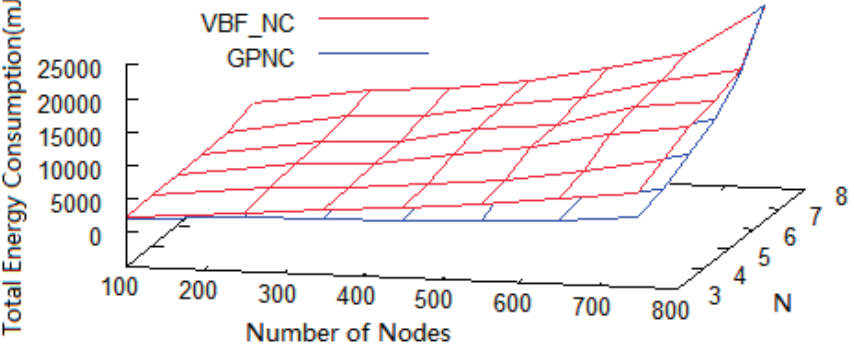
Figure 9. Energy consumption with the number of nodes and the value of N